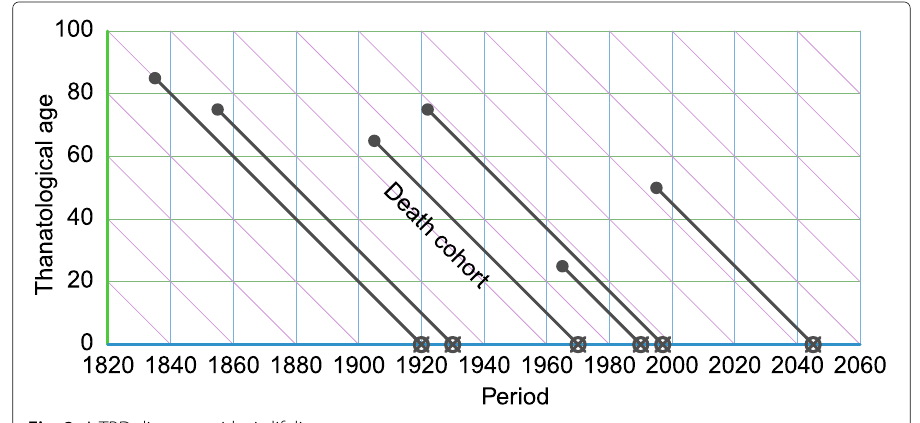
TPD: thanatological age, period, and death